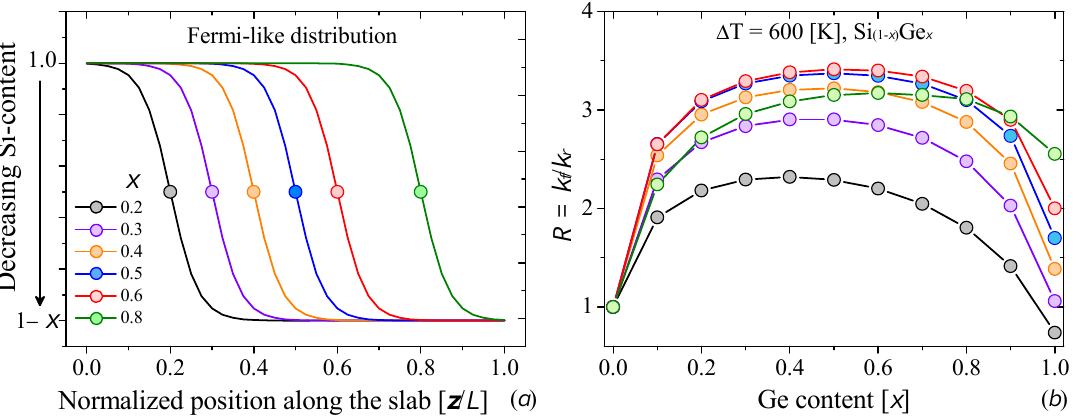
Figure 3. ( a ) Rectification factor as a function of Ge content for varying thermal bias ( ∆ T ), with Ge linearly distributed along the Si (1 − x ) Ge x alloy slab. ( b ) R as a function Ge content for the different distributions of Ge atoms along the alloy slab at fixed ∆ T = 600 [K].